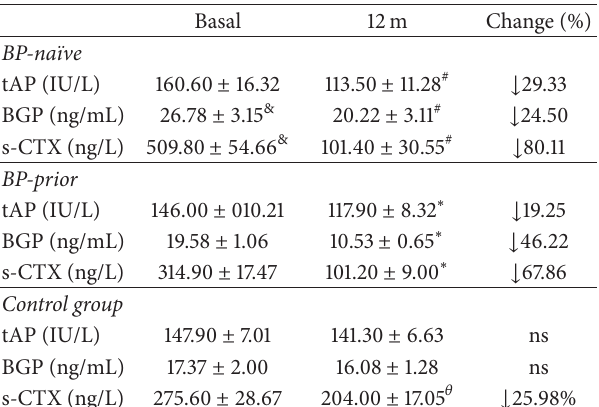
Table 2: Bone markers in patients treated with Dmab (BP-na¨ıve and BP-prior) and BP treated patients not switched to Dmab (control